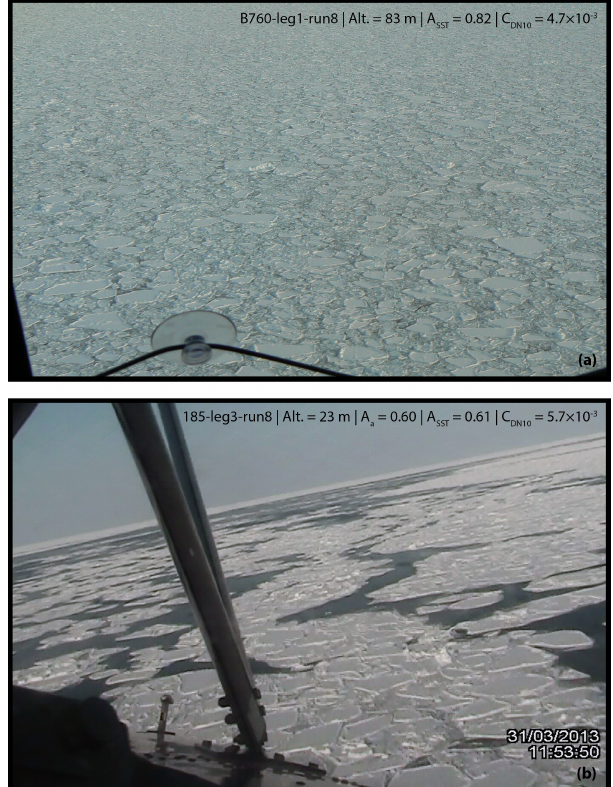
Figure 5. (a) Photograph taken from the FAAM aircraft during Flight B760 flux-run marked with an arrow in Fig. 7; and (b) still from video recorded from the MASIN aircraft during Flight 185. The image locations are marked in Fig.